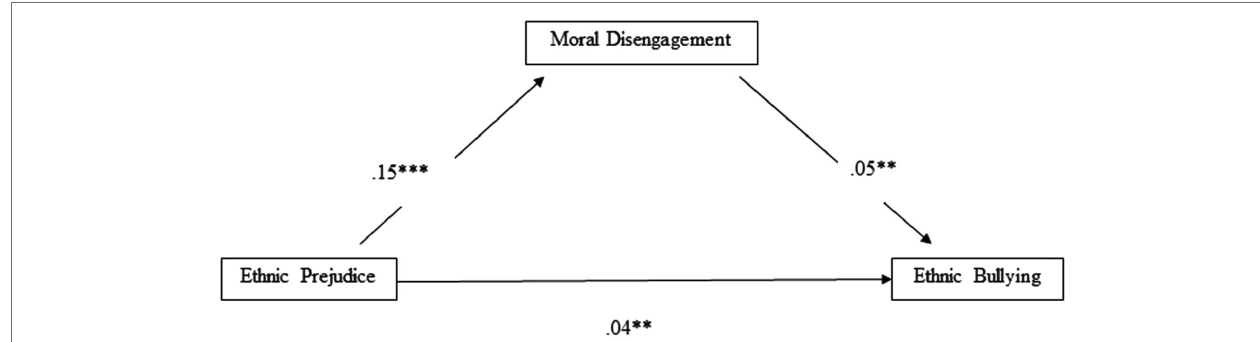
FIGURE 2 | Unstandardized regression coefficients of the mediation model. The covariates (gender, grade, and immigrant status) were not included in the figure. The indirect effect of ethnic prejudice on ethnic bullying via moral disengagement was also significant ( B = 0.01; SE = 0.01, 95% CI = 0.0003, 0.0197). ** p < 0.01; *** p < 0.001.